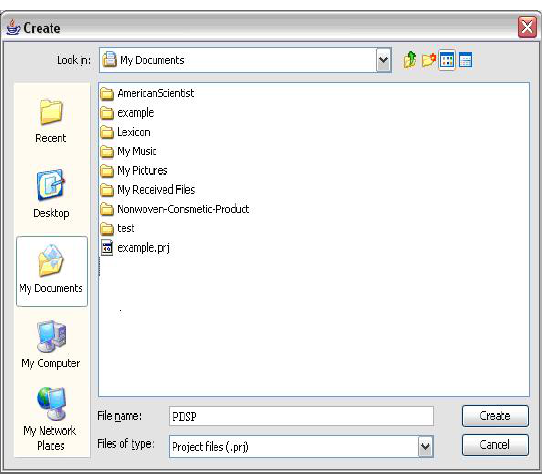
Fig.4. Creating a new project for evaluation